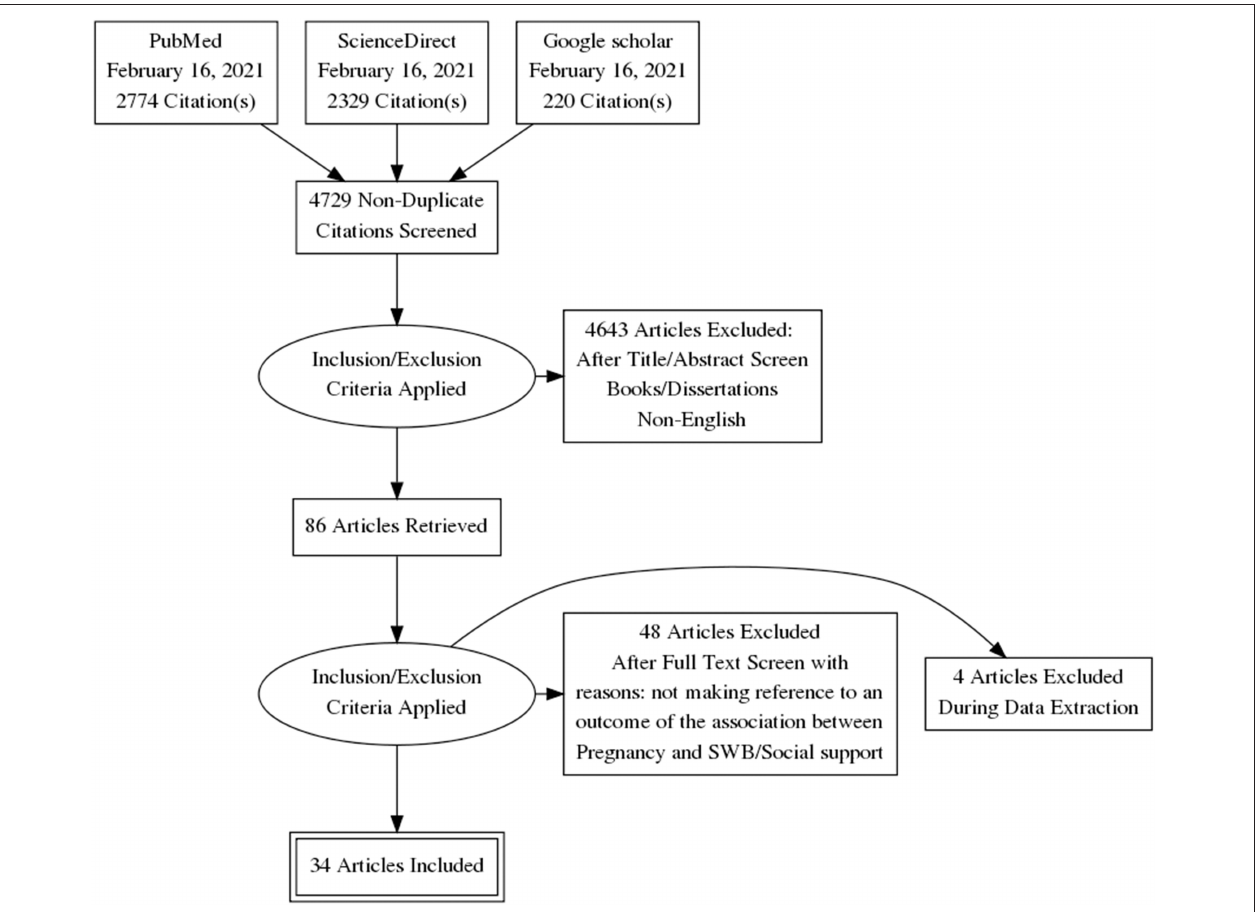
FIGURE 1 | Flowchart of the systematic literature search.